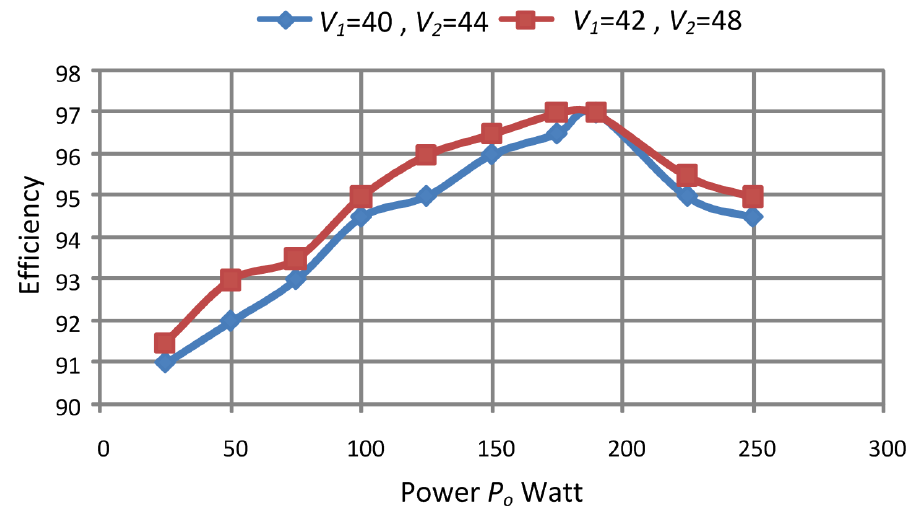
Figure 12. Measured efficiency